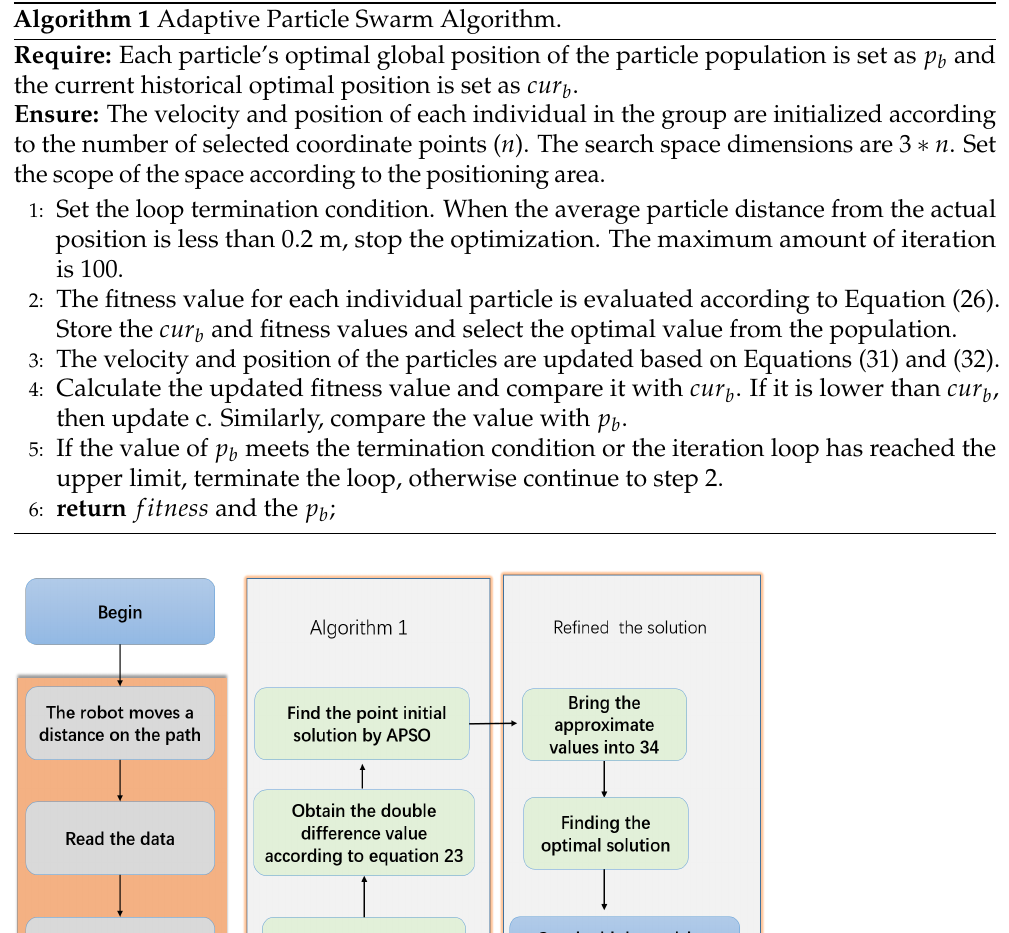
Algorithm 1 Adaptive Particle Swarm Algorithm.